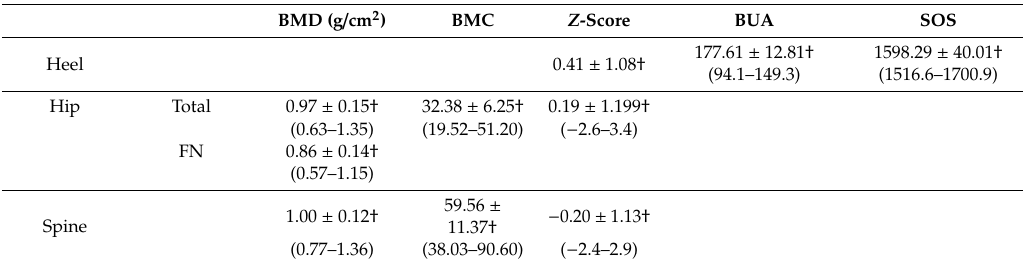
Table 3. Summary of bone parameters.